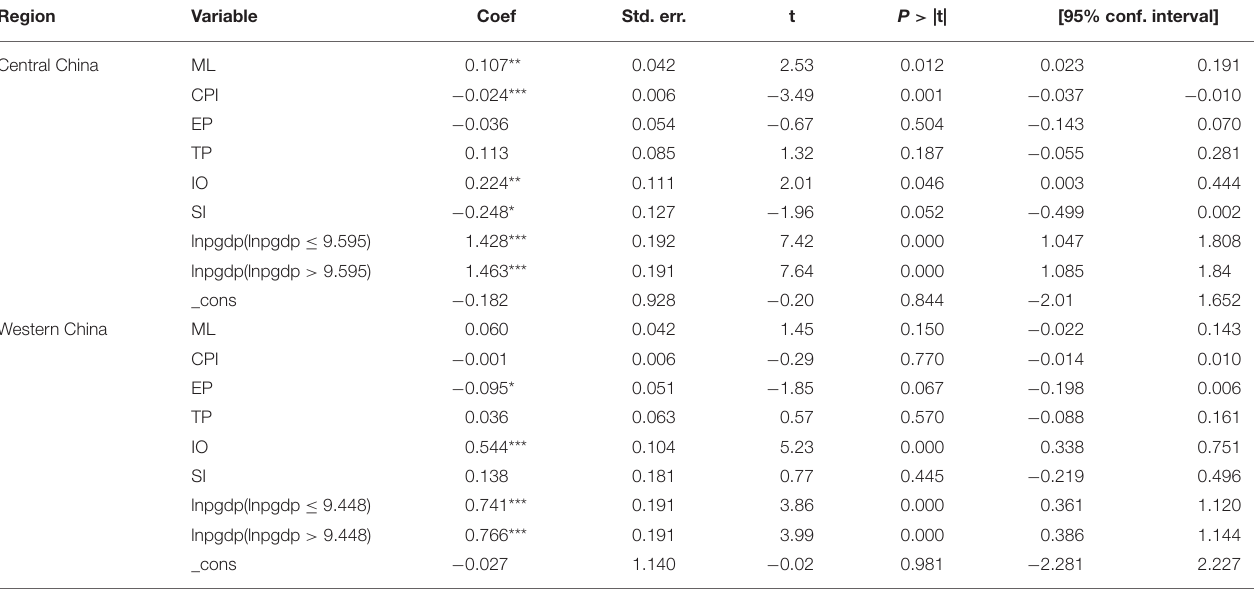
TABLE 7 | Estimated results of the threshold model for economic growth in Central and Western China.